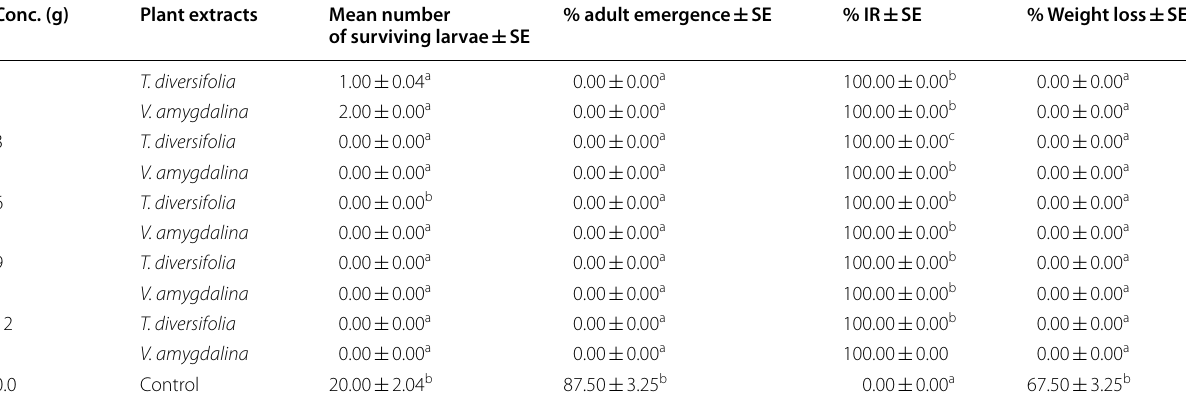
Mean followed by the same letters within the same column are not significantly different ( P >0.05)